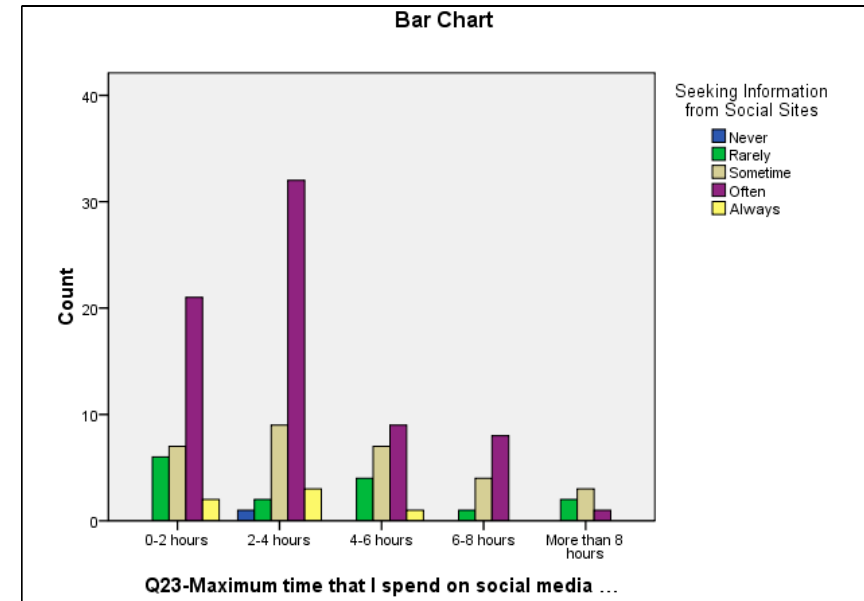
Figure 4. Time spent on social media and SIS. Table 4. Relationship between Time Spent on Social media and SIS practices. Seeking Information from Social Sites Never Rarely Sometime Often